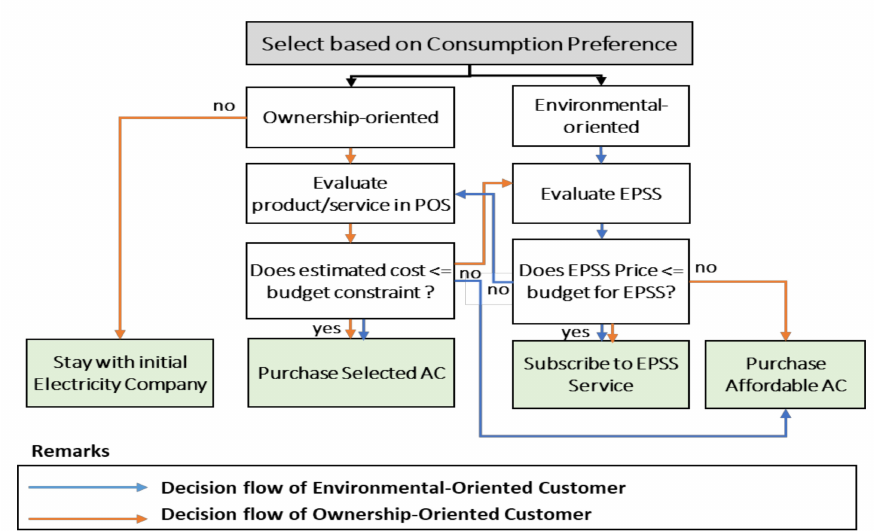
Figure 6. Customer Selection